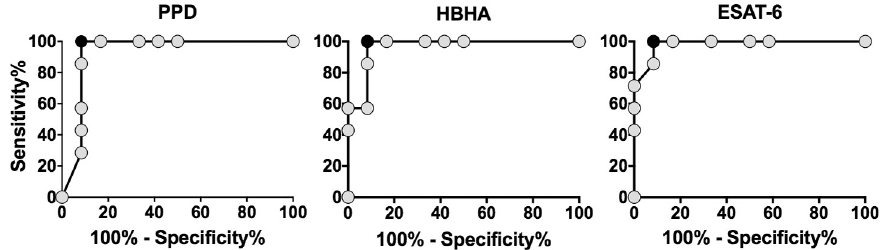
Fig 5. Receiver operator characteristics (ROC) curve analysis of the percentages of ascites IFN- γ -containing CD4 + lymphocytes obtained for TB and non-TB patients. The percentages of PPD-, HBHA-, and ESAT-6- induced IFN- γ - containing CD4 + lymphocytes were assessed by ROC analysis to define the most discriminant cut-off values between TB and non-TB patients. Cut-off values associated with optimal sensitivity and specificity were determined by the likelihood ratio analysis and are indicated by the black